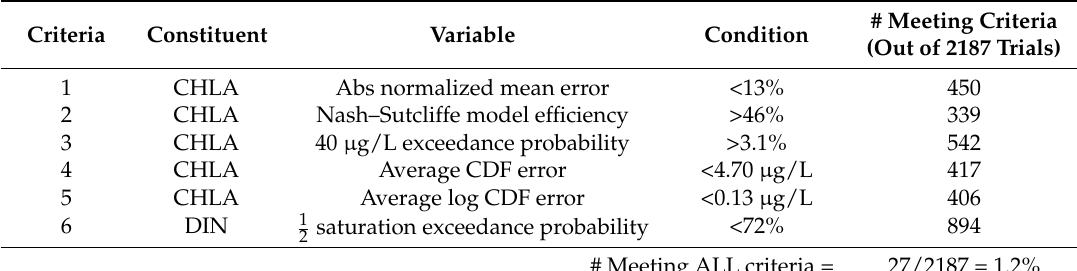
Table 3. Performance criteria for selection of algal growth parameter